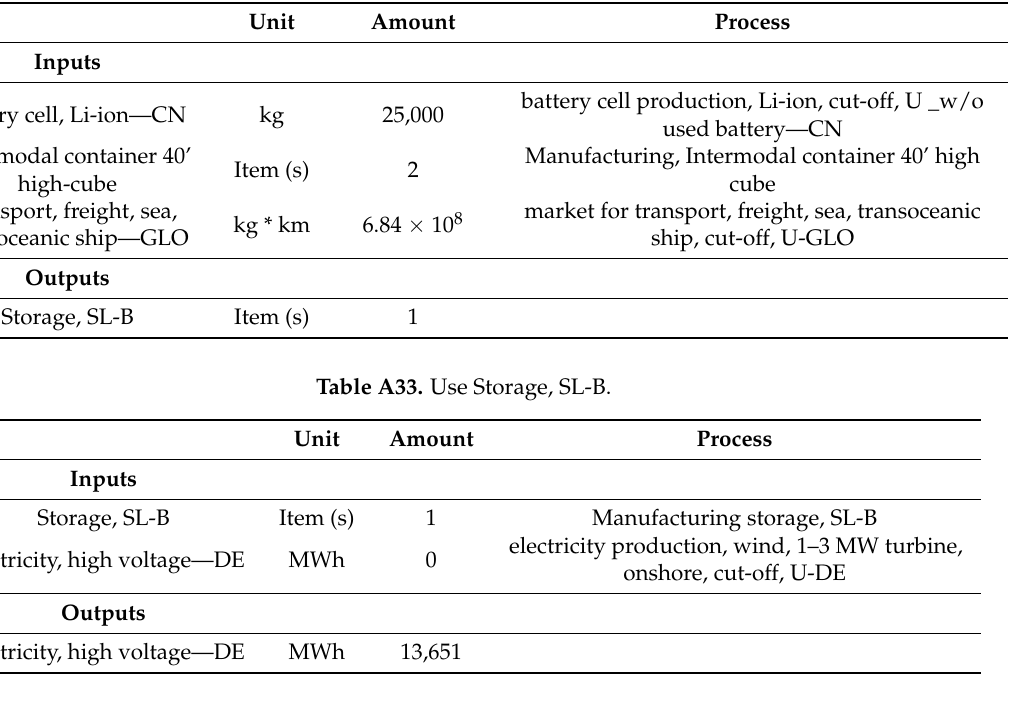
Table A32. Manufacturing Storage, SL-B.